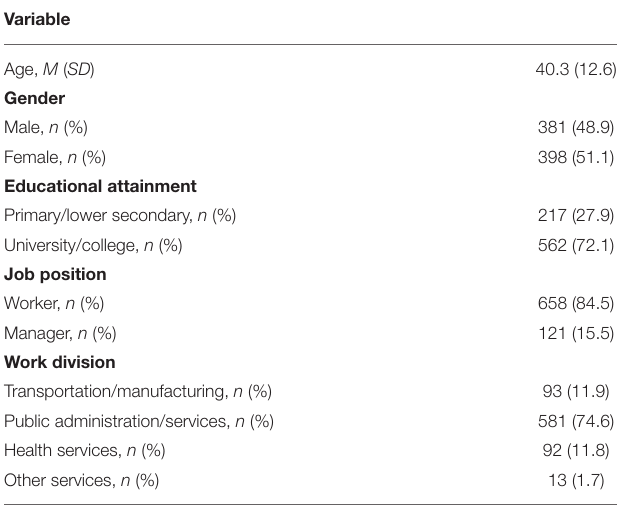
TABLE 1 | Characteristics of the study sample ( N =